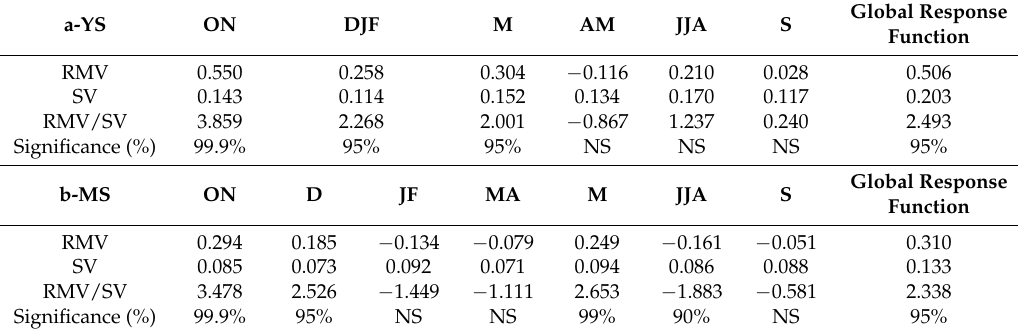
Table 1. Response function analysis of the residual tree ring chronology of Quercus suber to monthly precipitation from October ( t − 1) to September ( t ): a- for the period 1974–2002 in the young stand (YS) and b- for the period 1937–2002 in the mature stand (MS). Monthly climate values were averaged over selected periods October-November ( t − 1) (ON), December ( t − 1) to February ( t ) (DJF), March ( t ) M, April–May ( t ) (AM), June–August ( t ) (JJA), and September ( t )